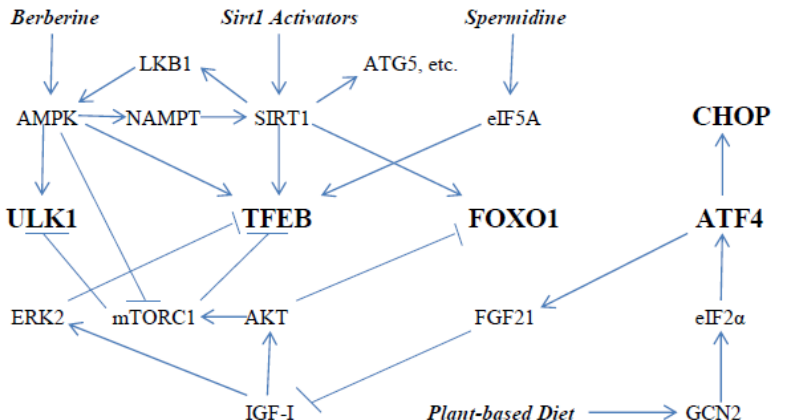
Figure 1. How nutraceuticals and diet can activate key mediators of autophagy—the initiating catalyst of autophagosome formation ULK1, and the transcription factors TFEB, FOXO1, ATF4 and CHOP, which promote expression of many proteins participating in autophagy. Sirt1 can activate some of these proteins (ATG5, LC3, Beclin1, etc.) via deacetylation. Sirt1 activators can include ferulic acid, melatonin, N1-methylnicotinamide, urolithin A, nicotinamide riboside, coenzyme Q10, glucosamine, aerobic exercise, and time-restricted feeding or intermittent